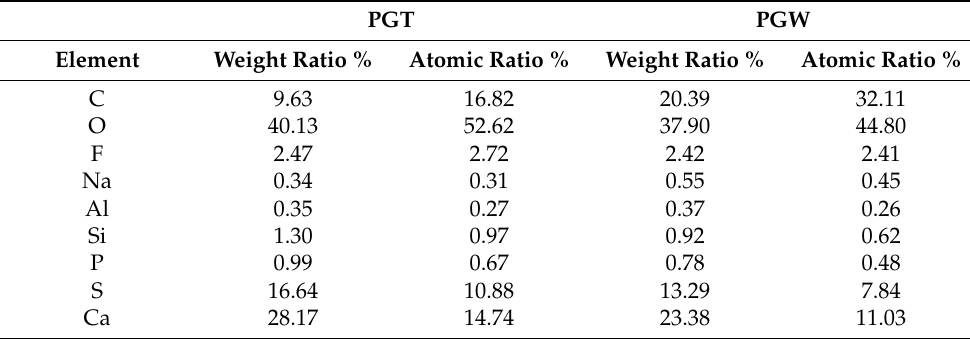
Table 5. Quantitative ratio of the elements in PGW and PGT.